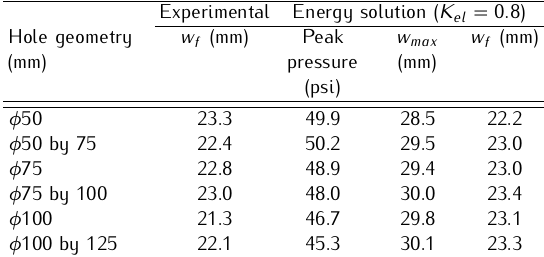
Figure 9. Pressure-time history for plate with φ 100 by 125 mm hole showing construction of idealised triangular pulse load